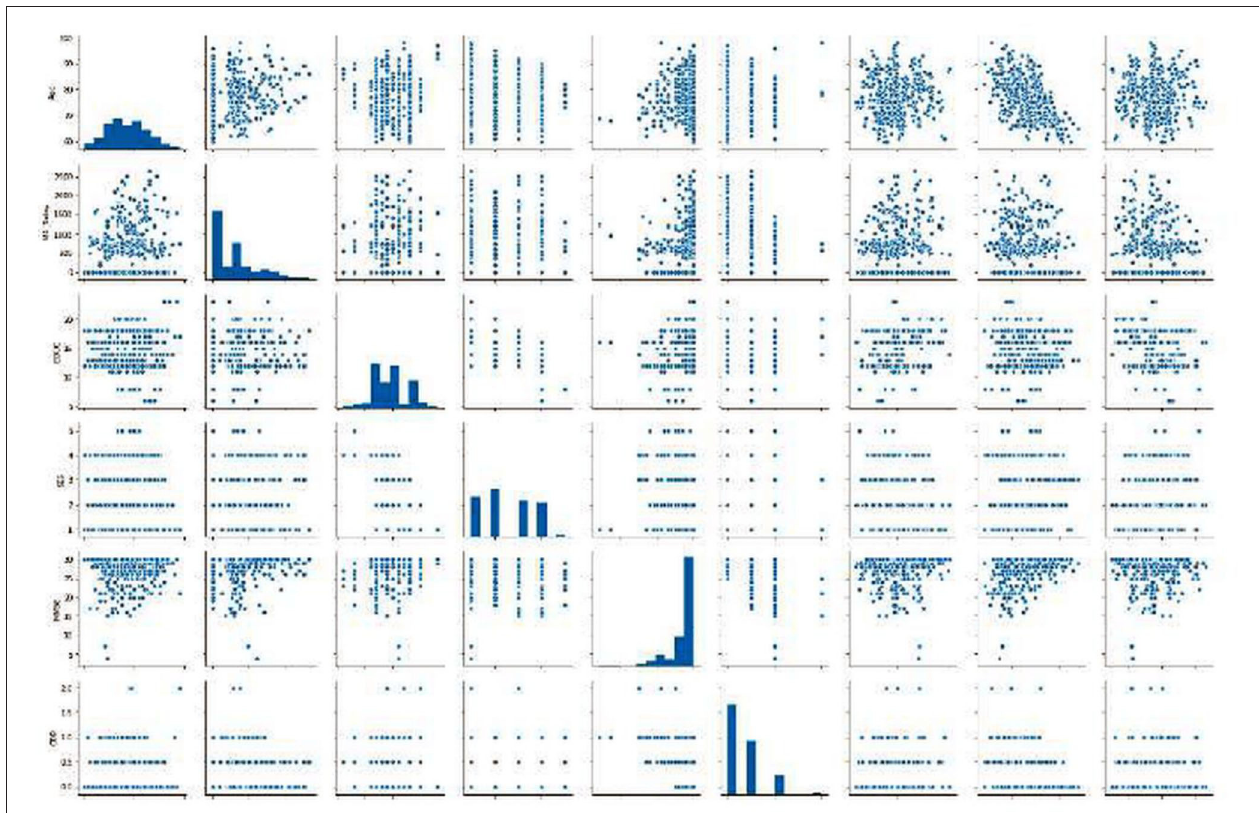
FIGURE 9 | Graphics of scatter plots representing the correlation matrix of individual parameters against the rest of the parameters in